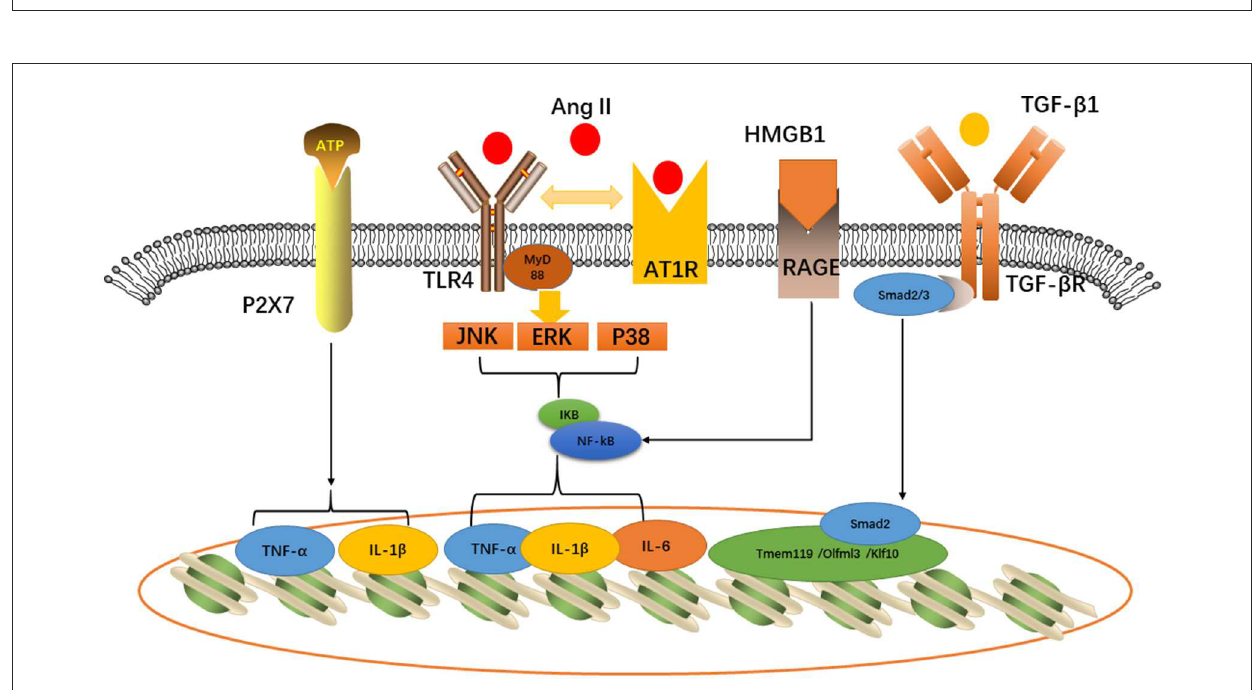
FIGURE2 Inflammatory pathways related to cardiovascular diseases expressed in microglia: P2X7, TLR4-AT1R, and HMGB1-RAGE would activate TNF- α , IL-6, and IL-1 β , while TGF- β would activate Tmem119/Olfml3/Klf10 induce microglia